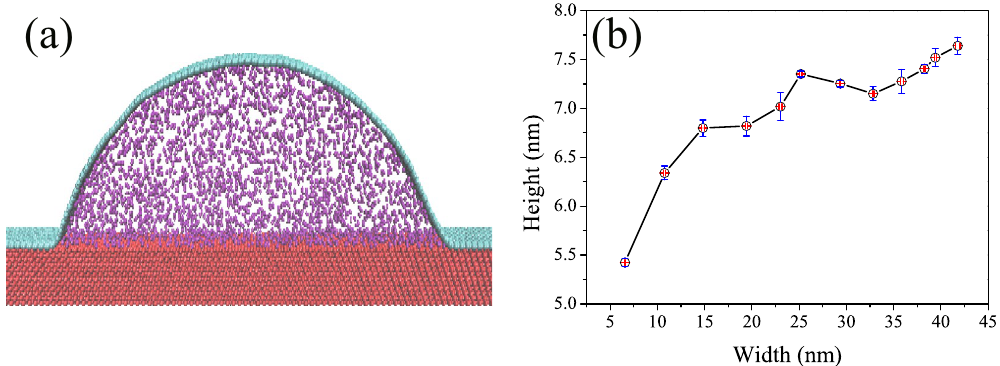
Figure 4. Typical MD simulation results of graphene wrinkle morphology with inter-molecules and the simulation results at temperature T = 300 K. ( a ) Typical MD simulation results of graphene wrinkle morphology with inter-molecules. The MD simulation model contains three parts, upper cyan graphene, interlayer hydrogen molecules and lower red copper substrate. ( b ) Simulation results of graphene wrinkles with various number of interlayer hydrogen molecules, the horizontal and vertical axis represents the width and height of graphene wrinkles. The error bars represent the standard deviation of five independent calculations for the same